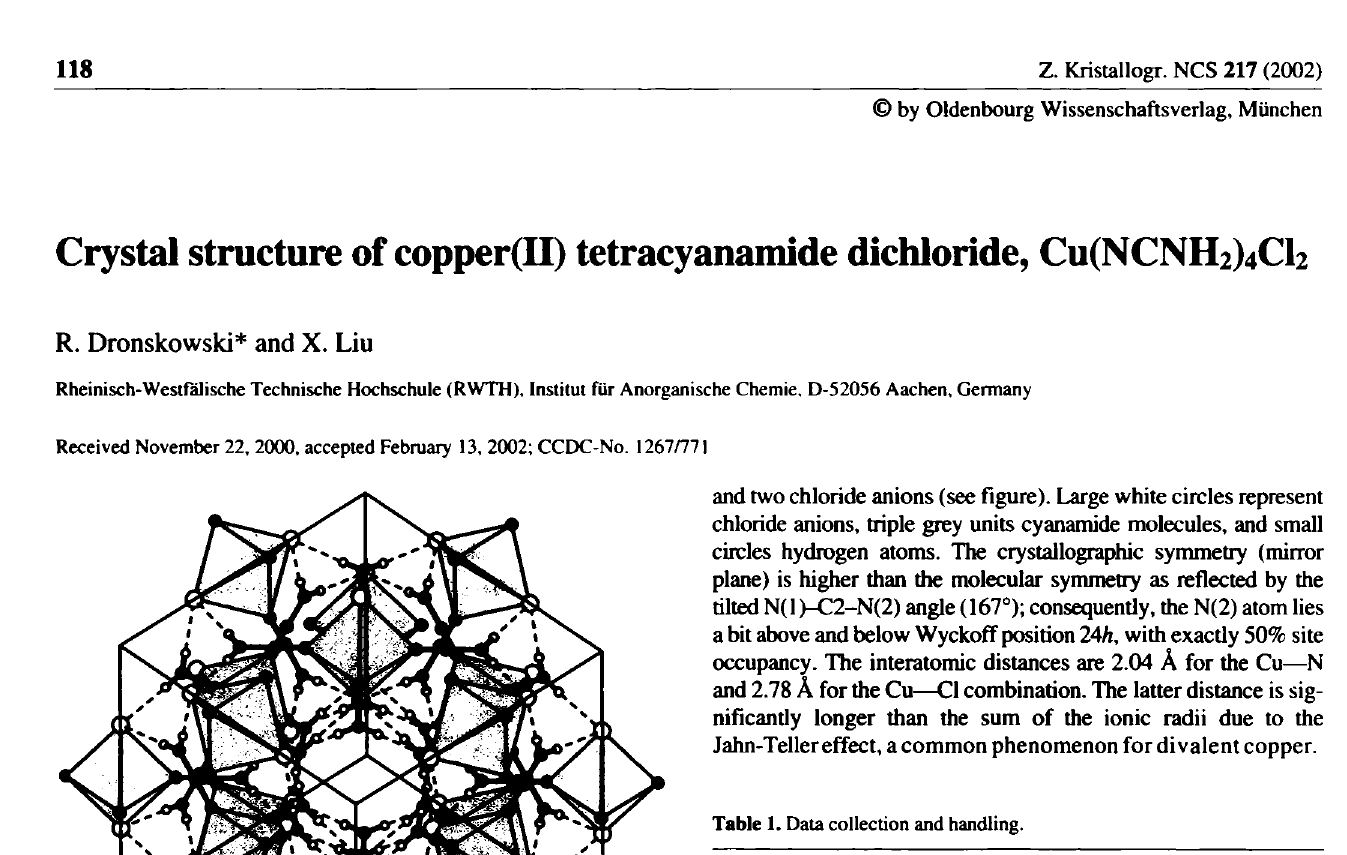
Table 2. Atomic coordinates and displacement parameters (in Â 2